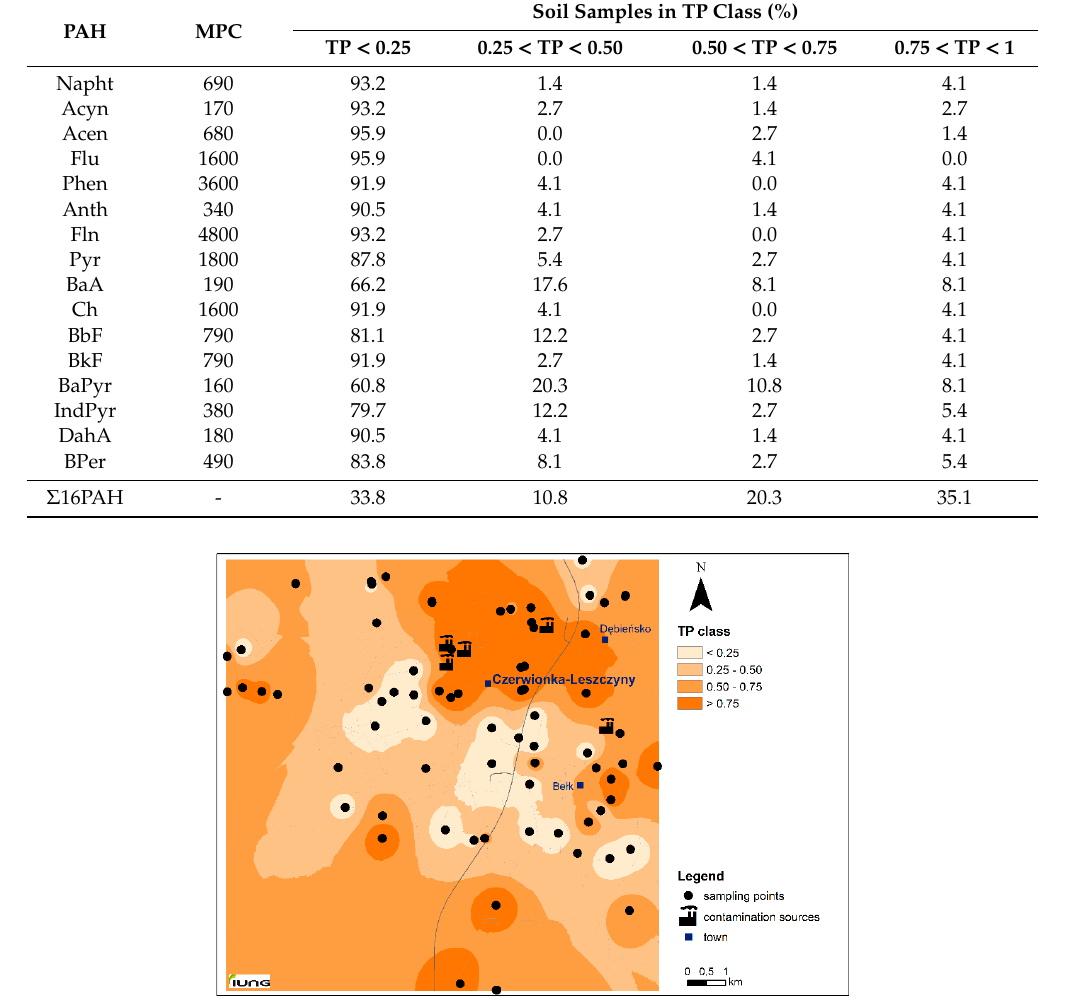
Figure 2. Spatial distribution of the toxic pressure (TPm) for 16PAHs in the study area; TP class limits according Dagnino et al. [15].